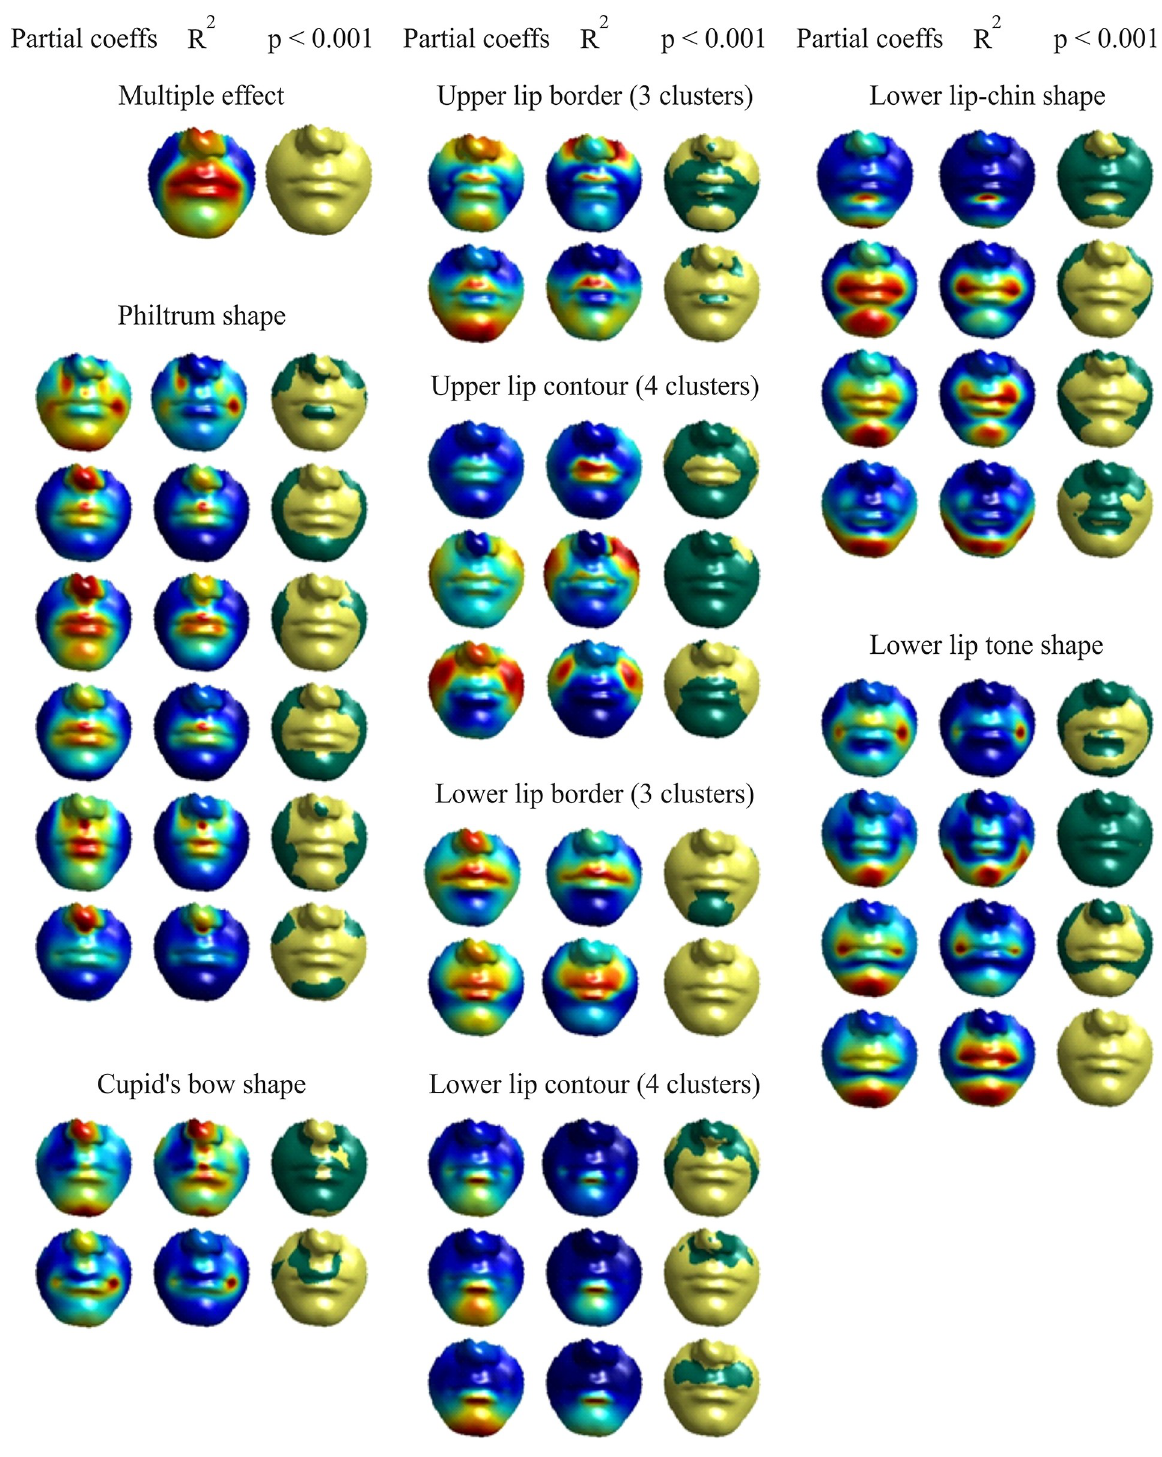
Fig 12. Visualisation of the effect of manual categories on the lower face based on the regression results for dummy variables. The ‘Partial coeffs’ columns display heat maps of the partial regression coefficients associated with mesh vertices (warmer colours correspond to stronger effects). The ‘ R 2 ’ columns display heat maps of proportion of the variance. The ‘ p < 0.001’ columns show two-colour maps of the statistical significance of the effect: yellow for p-value < 0.001 and green for p-value � 0.001.